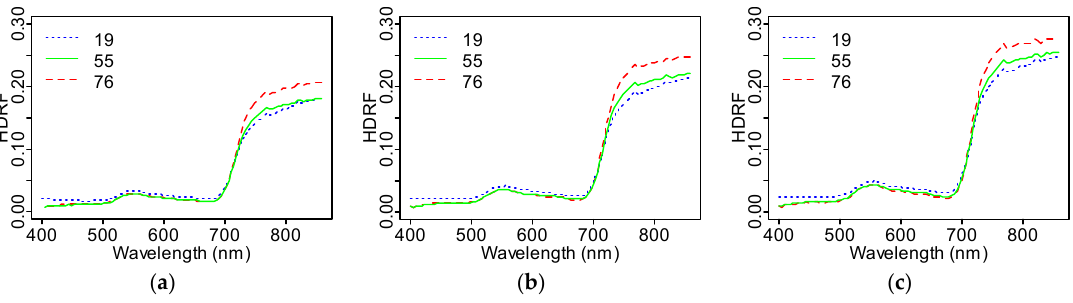
Figure 7. Average Scots pine canopy TOC reflectance for sunlit fraction 0.26–0.29 ( a ); 0.35–0.36 ( b ); and 0.43–0.45 ( c ).